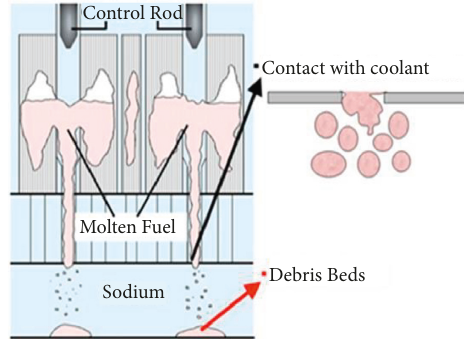
Figure 1: The formation of debris bed.